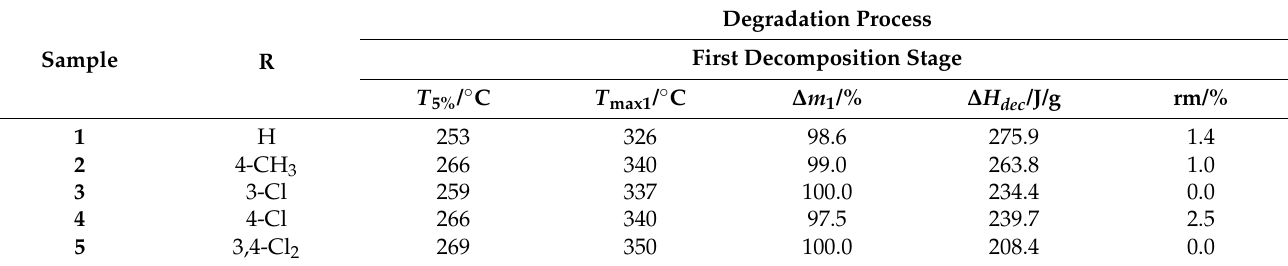
Figure 3. The TG ( a ), DTG ( b ) , and DSC ( c ) curves of compounds 1 – 5 (a helium atmosphere). Table 2. The TG/DTG data for compounds 1 – 5 (a helium atmosphere).